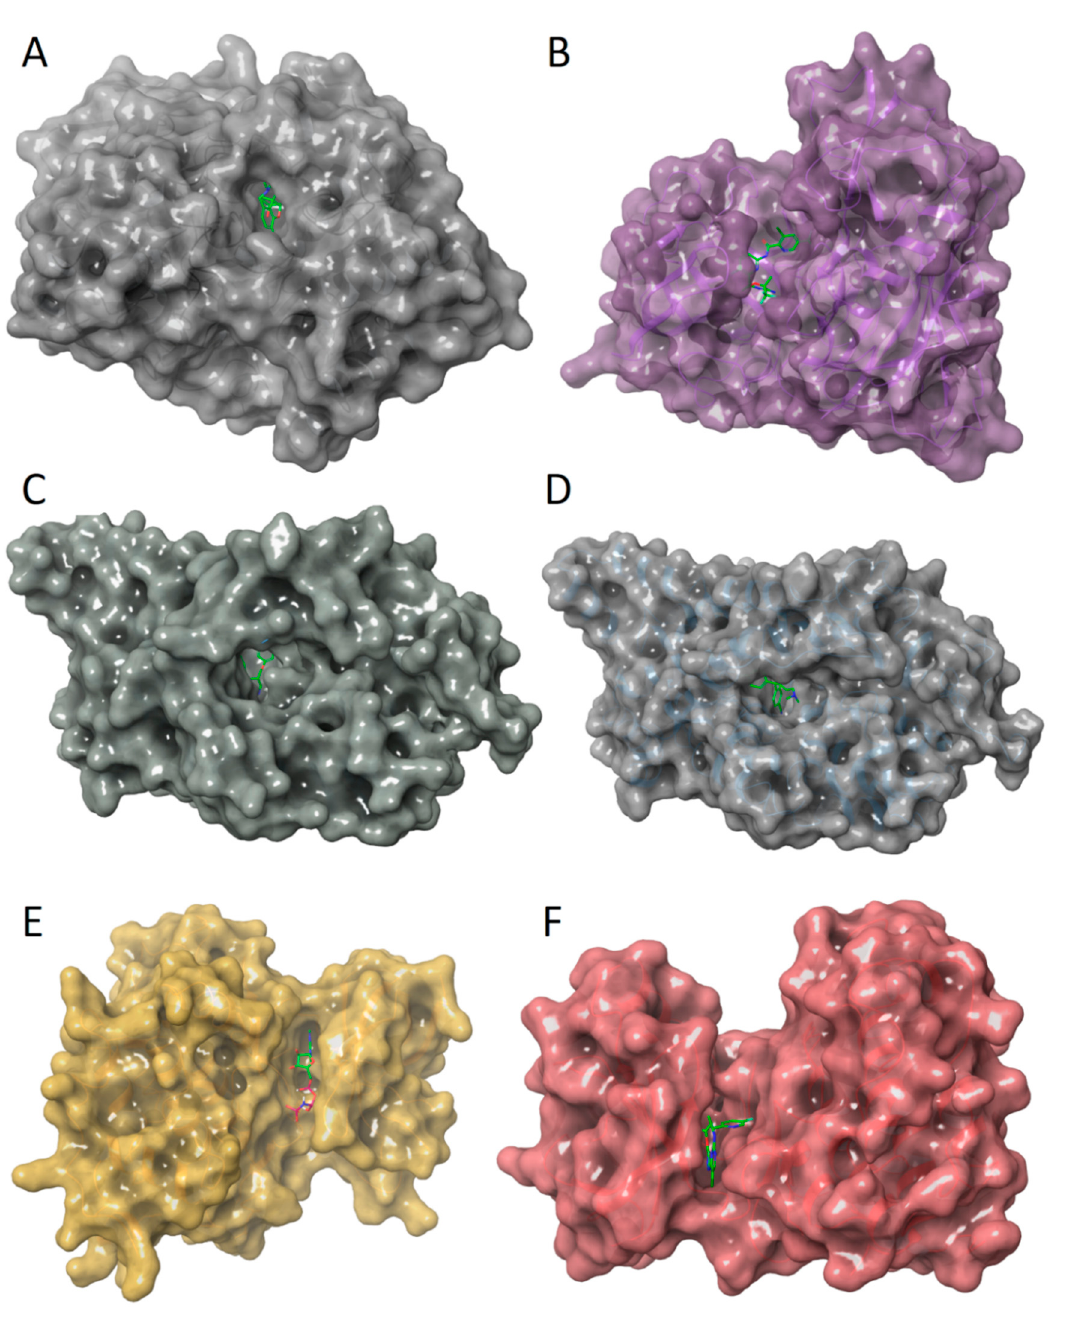
Figure 1. Selected target proteins: ( A ) human AChE in complex with (-)-galantamine (PDB ID: 4EY6); ( B ) human BACE1 in complex with inhibitor CNP520 (PDB ID: 6EQM); ( C ) ts3 human SERT in complex with paroxetine at the central site (PDB ID: 5I6X); ( D ) ts3 human SERT in complex with S -citalopram at the allosteric site (PDB ID: 5I73); ( E ) human GSK3 β in complex with non-selective ATP-mimetic inhibitor (PDB ID: 1PYX); ( F ) human TrkA in complex with the inhibitor AZ-23 (PDB ID: 4AOJ). All target proteins are shown as a molecular surface, and the co-crystallized ligands are stick models colored green (carbon), blue (nitrogen), red (oxygen) and purple (phosphorus).